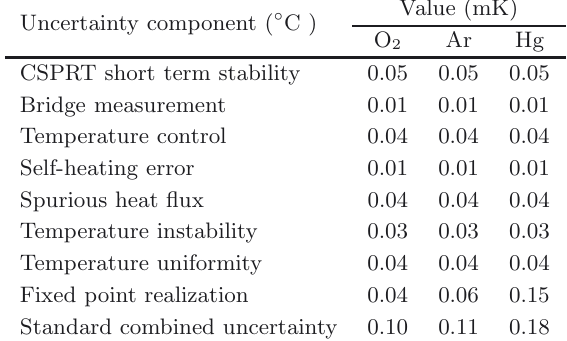
Table 1. Uncertainty budgets for the calibration of CSPRTs at temperatures close to fixed points using the comparison